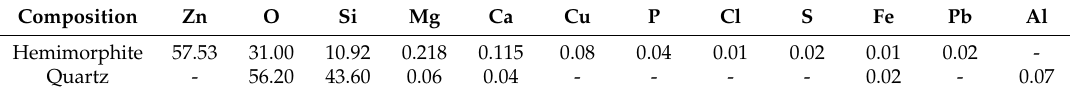
Figure 1. X-ray Diffraction (XRD) of hemimorphite ( a ) and quartz ( b ) samples. Table 1. The element content of hemimorphite and quartz by X-ray fluorescence (XRF) (wt %).